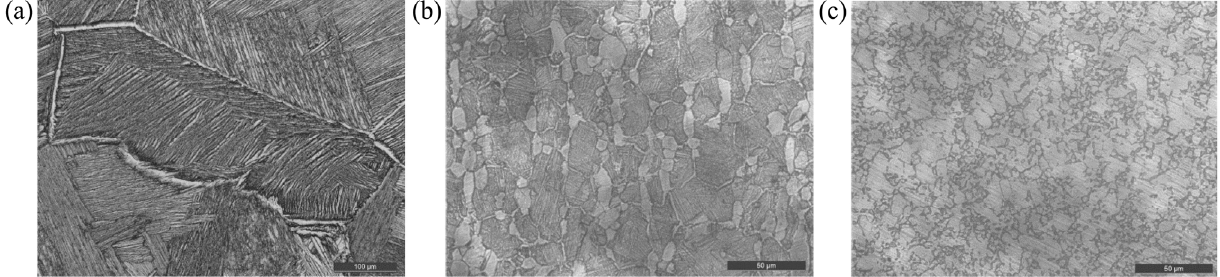
Fig. 1 Microstructures of Ti and its alloys developed at various heat treatment conditions: (a) lamellar; (b) bi-modal; (c) equiaxed. Reproduced with permission from Ref. [50]. Copyright Springer Nature, 2014